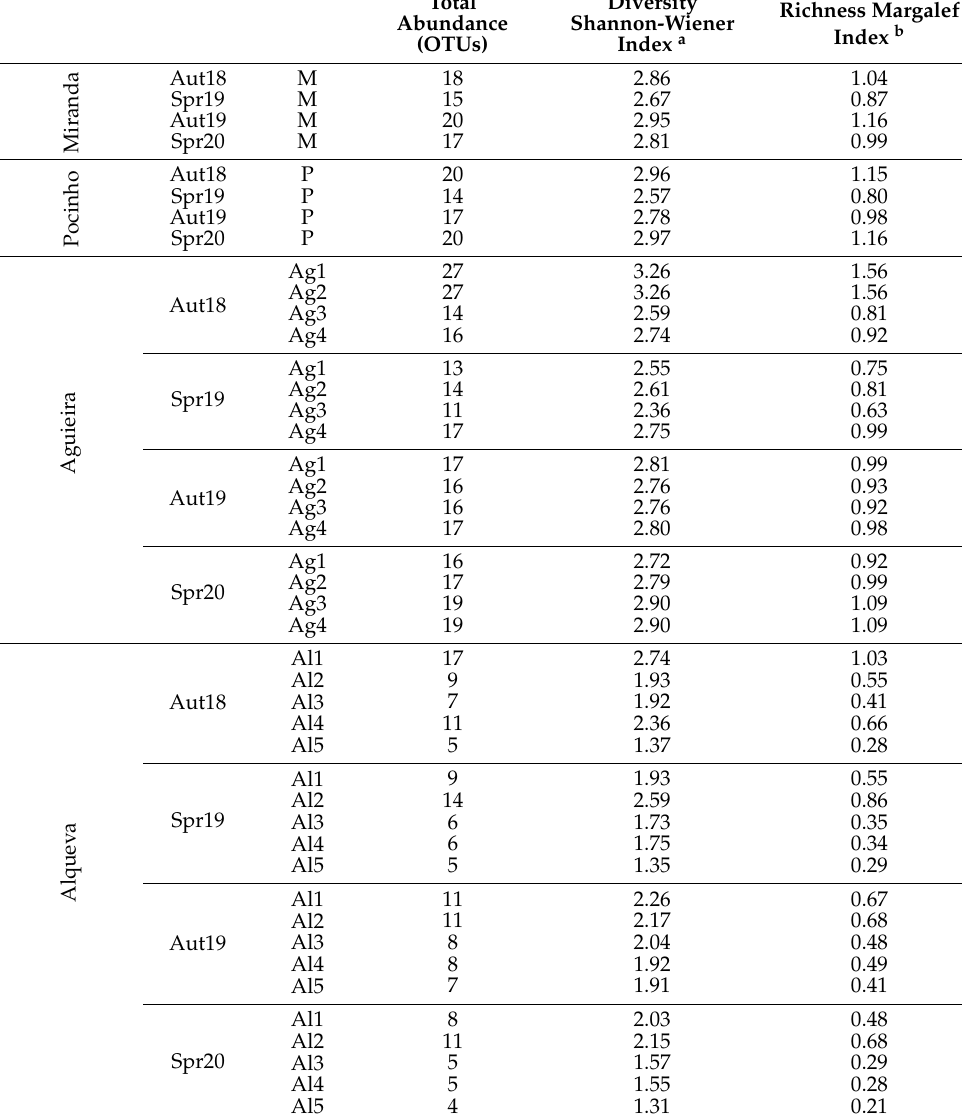
Table 2. Results of total abundance (average number of operational taxonomic units—OTUs), diversity—Shannon-Wiener and richness—Margalef indexes of bacterioplankton communities